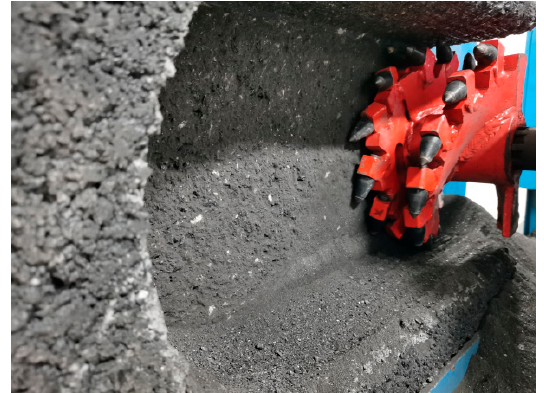
Figure 4. Shearer cutting experiment.